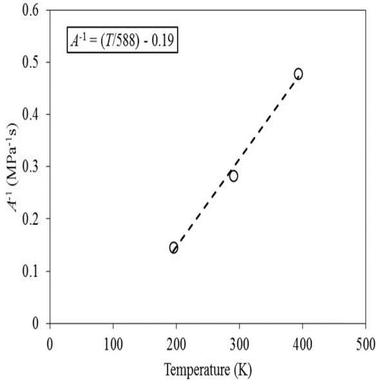
Temperature-dependence of thermal stress strain-rate scaling term: comparison of linear fit with experimentally-based results.